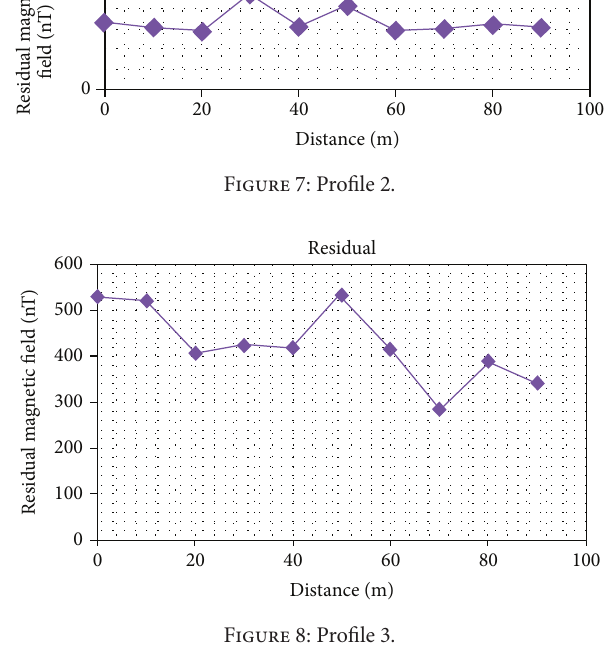
Figure 4: 2D contour map of the study area.